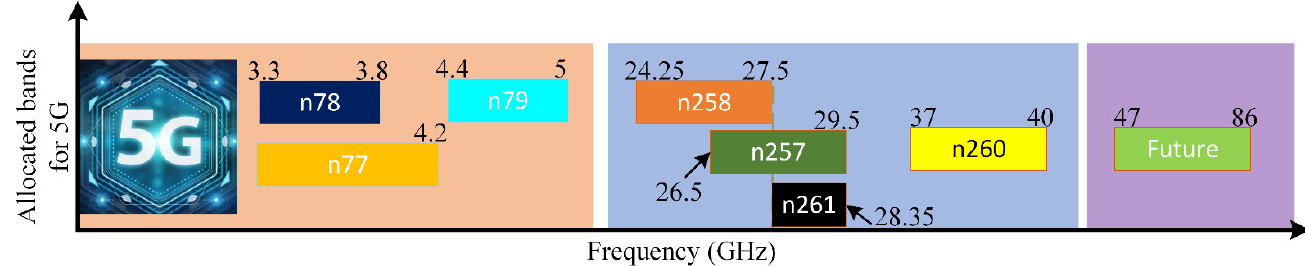
Figure 1. 5G allocated bands, the concept has been obtained from [20].